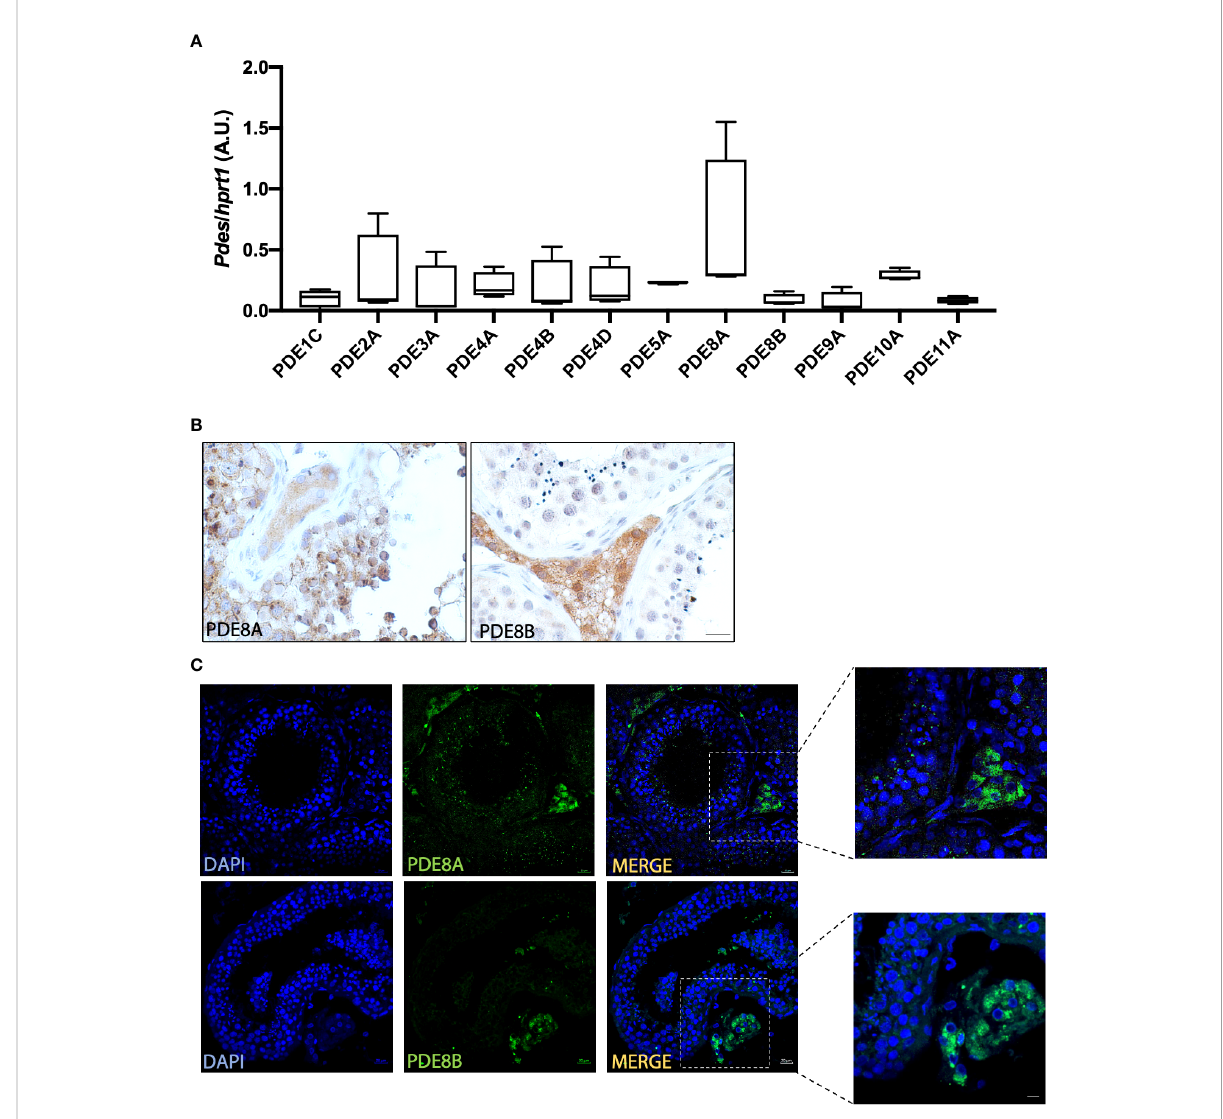
FIGURE 1 PDEs expression analysis in human testis (A) PDEs mRNA expression analysis by QuantiGene Bioplex Assay on human testis biopsies from healthy subjects. Results, normalized for HPRT1, are expressed as arbitrary units (A.U, (median and 5-95 percentile) and reported in the histogram bar chart (n=4). (B) PDE8 isoforms expression analysis by immunohistochemistry using commercially available anti-PDE8A and anti- PDE8B antibodies on human testis biopsies. Scale bars represent 20 m m. (C) Localization of PDE8 isoforms by immuno fl uorescence analysis on sections obtained from human testis biopsies of healthy subjects. PDE8 isoforms staining is shown in green and nuclei are shown in blue (DAPI). Scale bars represent 20 m m except for the insets where they represent 10 m